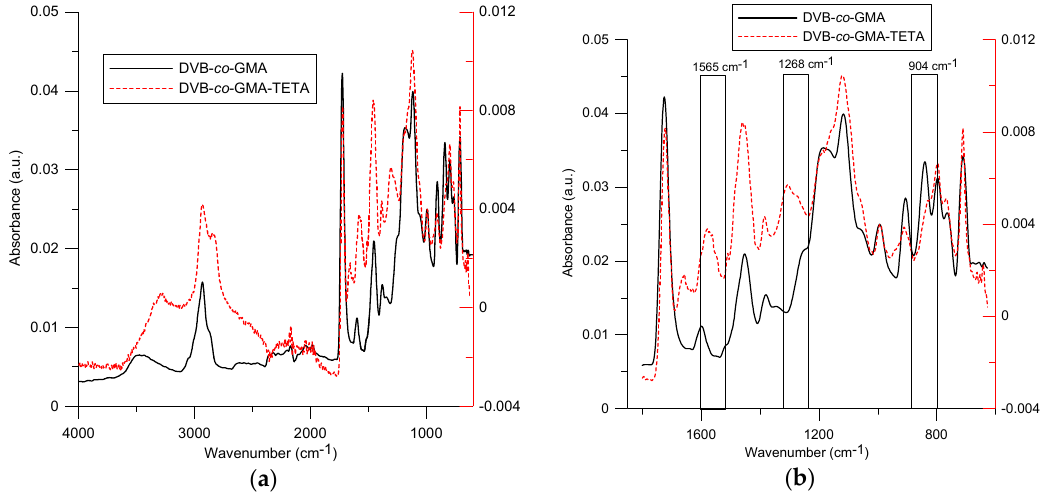
Figure 3. ATR-FT-IR spectra of DVB- co -GMA and DVB- co -GMA-TETA copolymers in the ranges: ( a ) 4000–750 cm − 1 and ( b ) 600–1800 cm − 1 .